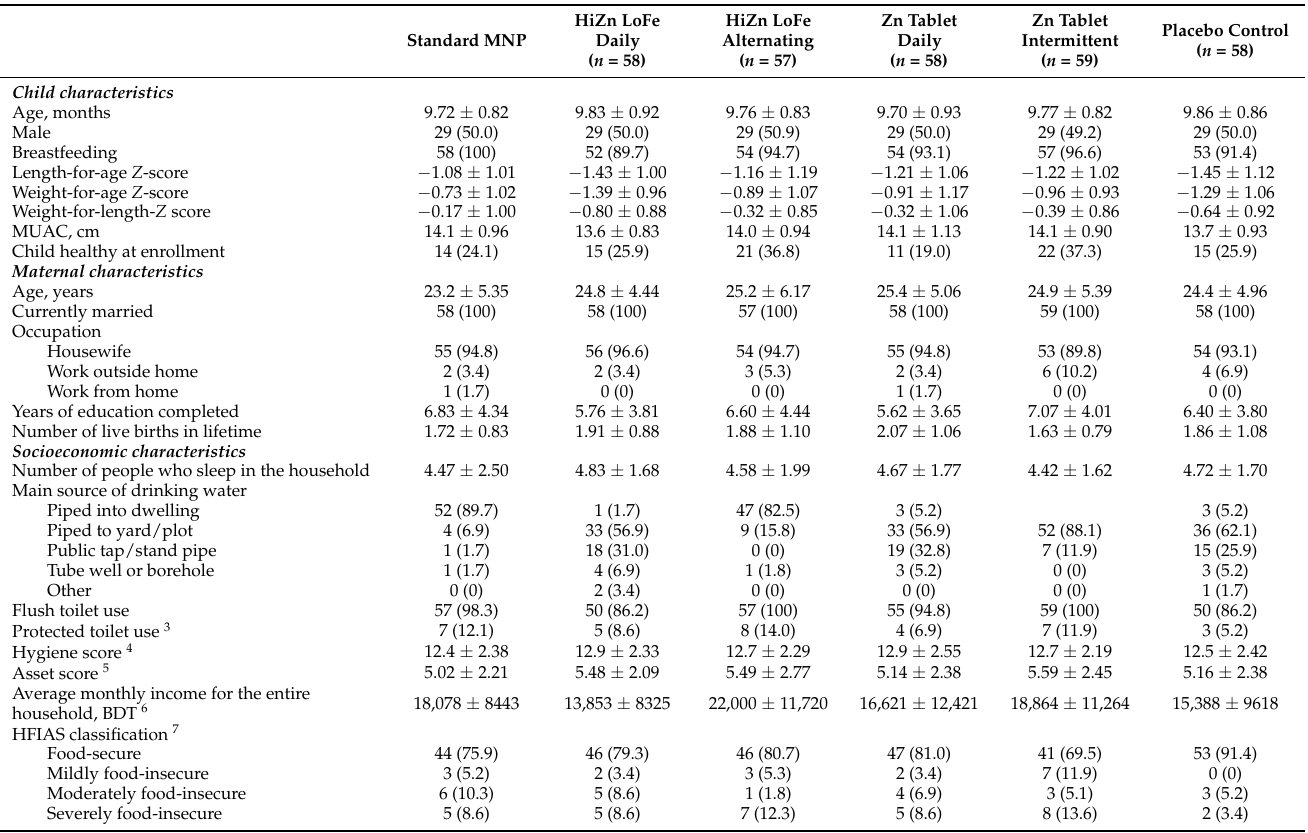
Table 1. Baseline characteristics of children in the biochemistry subgroup and their mothers by group assignment 1,2 . HiZn LoFe Standard MNP